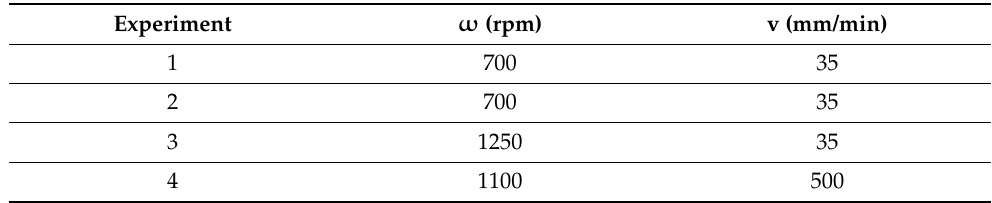
Table 1. FSW list of